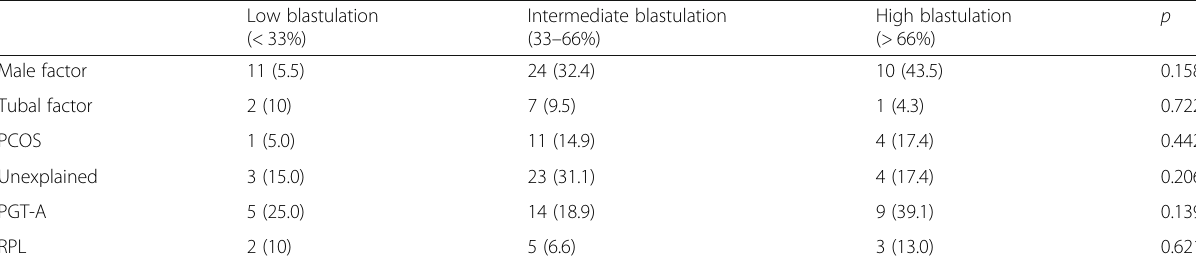
Table 3 Infertility diagnosis for variable blastulation rates